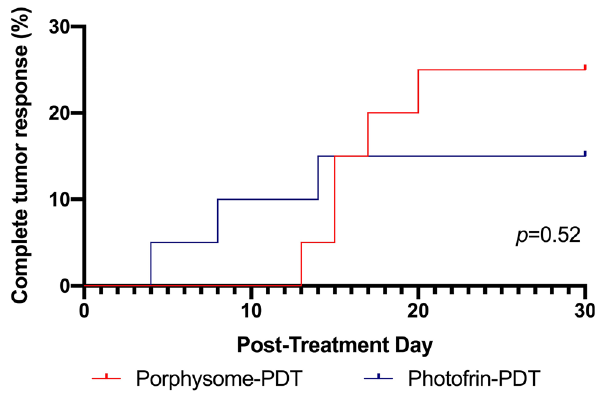
Figure7: Completetumorresponsesinporphysome-PDT(10mg/kg, 24 h DLI, n = 20) and Photofrin-PDT (5 mg/kg, 24 h DLI, n =